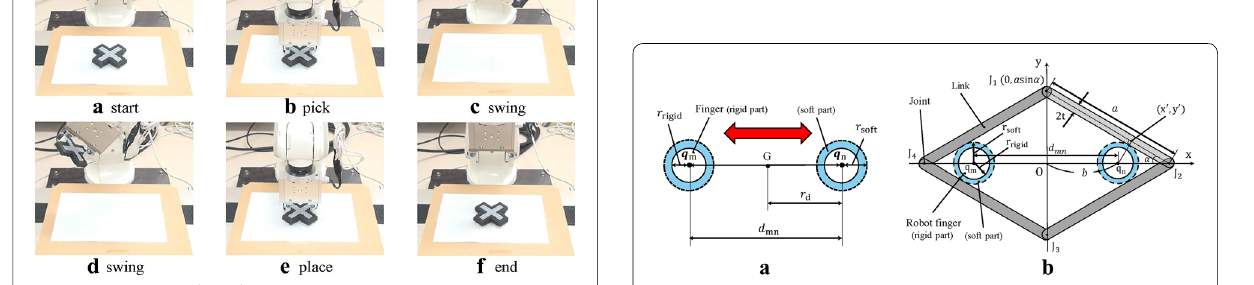
Fig. 10 Experimental results Fig. 11 Closed-loop structure. a Hand and b object